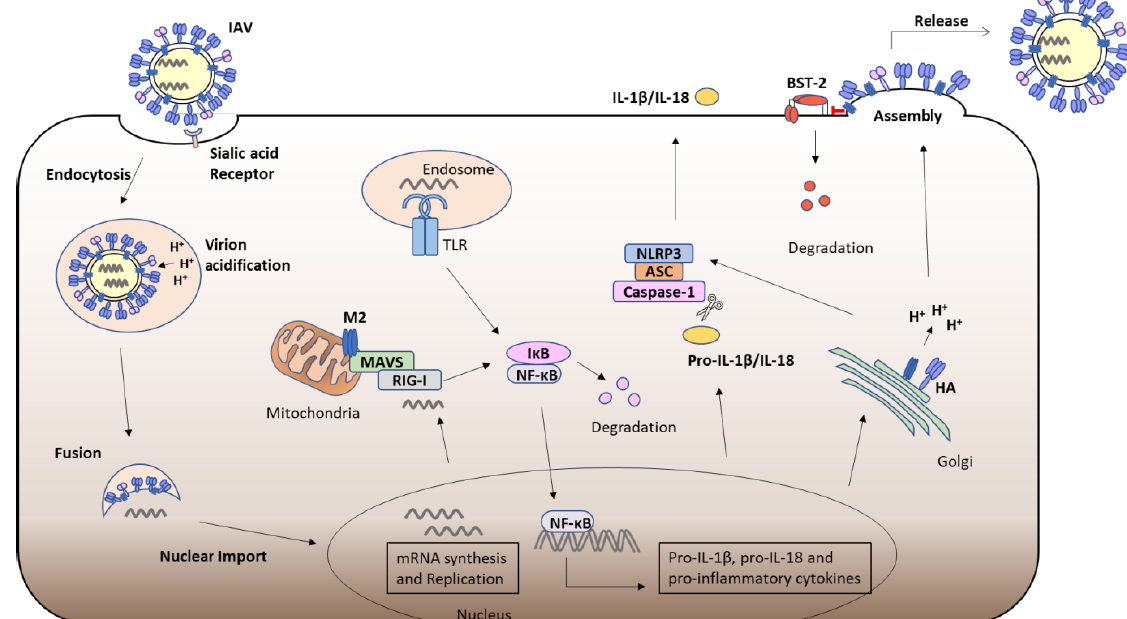
Figure 2. IAV M2 viral ion channel. The ion channel activity of M2 plays an important role in the IAV life cycle. IAV binds to sialic acid receptors on host target cells and is subsequently endocytosed. The ion channel activity of M2 allows for acidification of the virion causing dissociation of vRNPs. M2 then modifies the pH of the Golgi apparatus allowing for HA